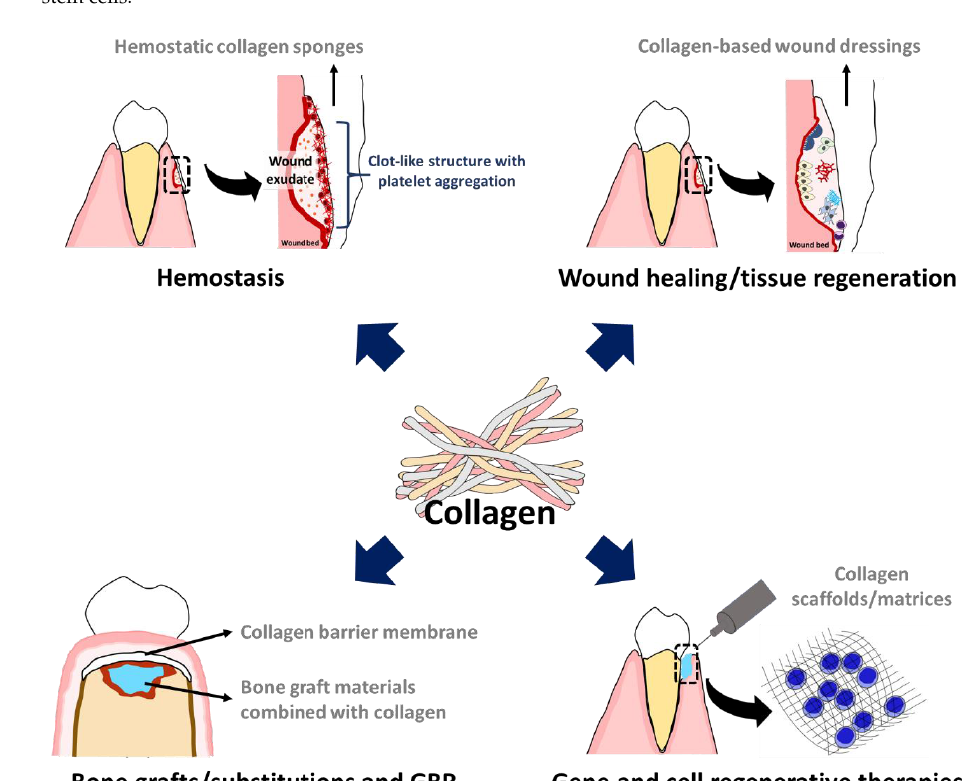
Figure 2. Application of collagen as biomaterials for periodontal regeneration. Collagen is commonly used as hemostatic materials, wound dressing products for healing and regeneration, bone grafting materials for bone substitution and GBR, and scaffolds / matrices for gene and cell regeneration therapies .